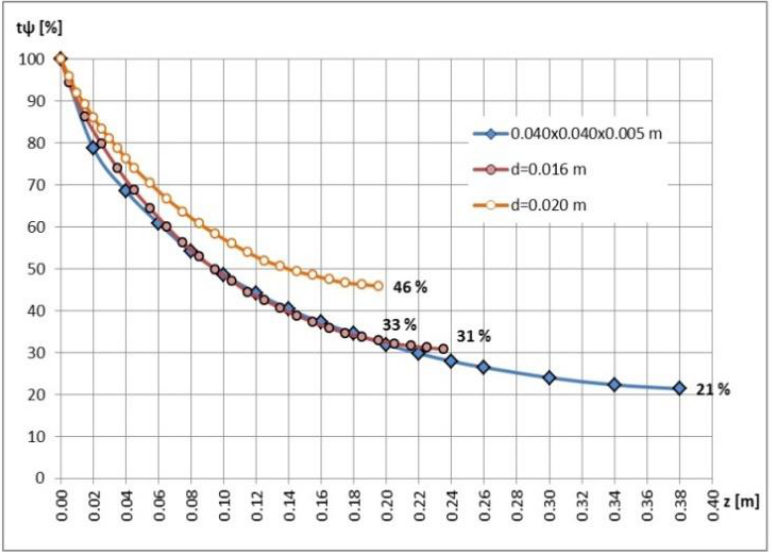
Figure 11. The comparative, relative t ψ [ % ] thermal distribution laws for α g = 0 ◦ and t O , n = 400 ◦